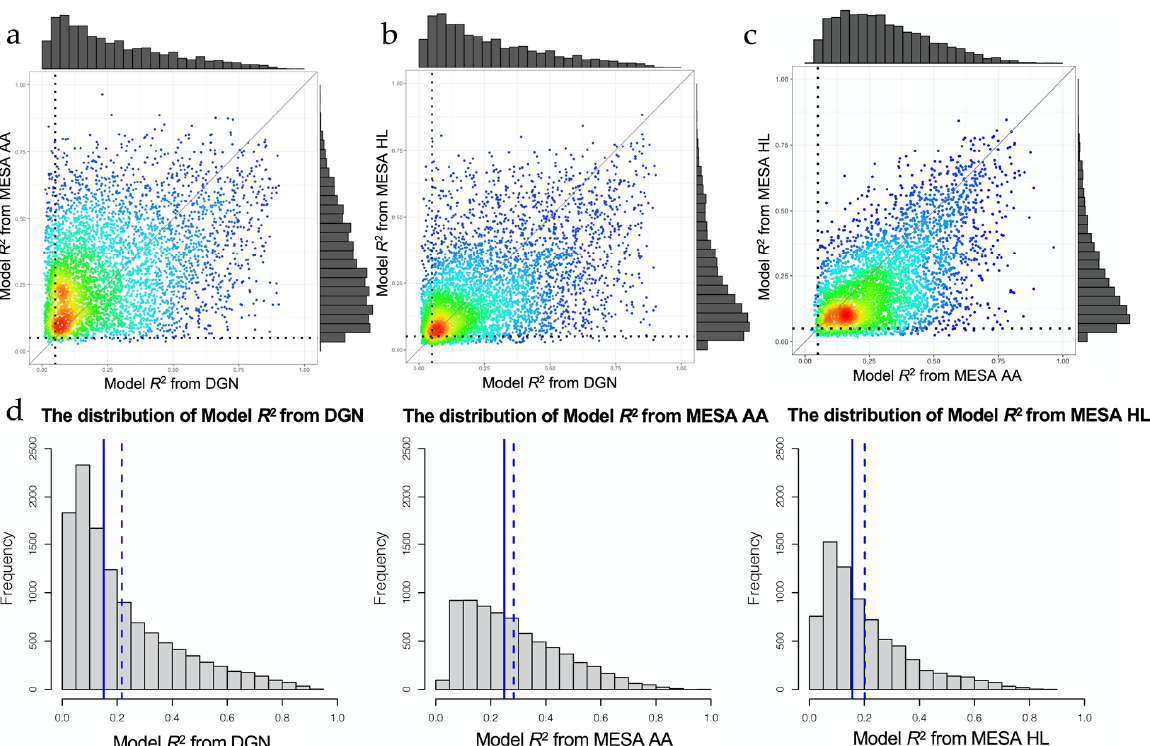
Figure 3. The smooth scatter plots show the model R 2 distribution of common genes available in both the Depression Genes and Networks (DGN) European and Multi-Ethnic Study of Atherosclerosis (MESA) reference eQTL datasets. The dashed line denotes the threshold value (model R 2 = 0.05) for well-predicted genes. ( a ) Comparison of model R 2 of common genes found in both Depression Genes and Networks (DGN) and Multi-Ethnic Study of Atherosclerosis (MESA) African ancestry (AA) reference panels; ( b ) Comparison of model R 2 of common genes between the Depression Genes and Networks (DGN) and Multi-Ethnic Study of Atherosclerosis (MESA) Hispanic/Latino (HL) reference panels; ( c ) Comparison of model R 2 of common genes between the Multi-Ethnic Study of Atherosclerosis (MESA) African ancestry (AA) and Multi-Ethnic Study of Atherosclerosis (MESA) Hispanic/Latino (HL) reference panels; ( d ) Histograms showing the model R 2 distribution of all genes in each reference panel (without model R 2 filtering). The blue solid line denotes the median of model R 2 ; the blue dashed line denotes the mean of model R 2 . All genes, including those which do not meet a model R 2 = 0.05 cut-off, are